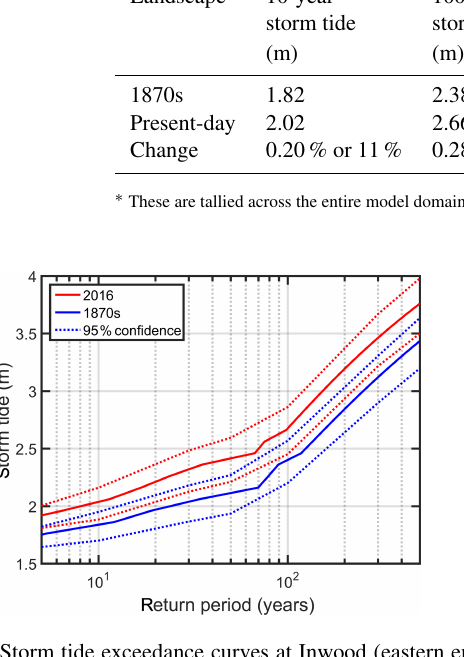
Figure 6. Storm tide exceedance curves at Inwood (eastern end of the bay) for the 1870s and present-day Jamaica Bay landscapes. Storm tide is the water level above mean sea level, and storms for both cases were simulated with the mean sea level for 2016.